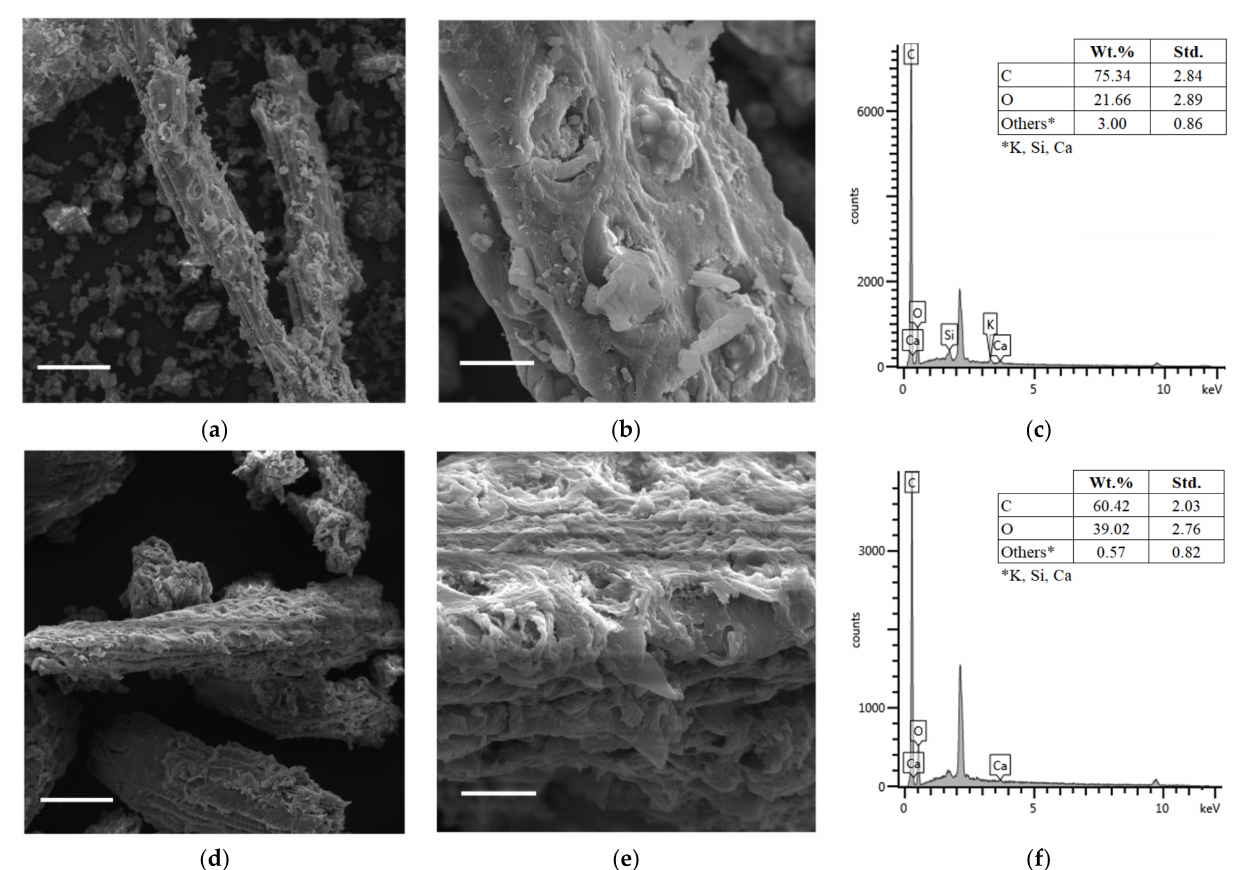
Figure 3. SEM-EDS results of the aça í fibers. In natura: ( a ) [ × 1000; scale = 50 µ m]; ( b ) [ × 5000; scale = 10 µ m]; ( c ) EDS spectrum. Treated: ( d ) [ × 1000; scale = 50 µ m]; ( e ) [ × 5000; scale = 10 µ m]; ( f ): EDS spectrum.